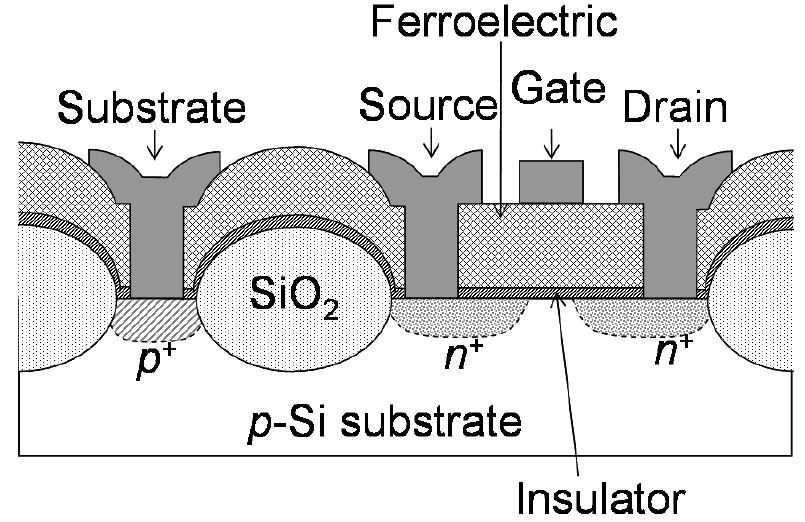
Figure 2. Drain current-gate voltage curves of an n -channel Pt/SBT/Hf-Al-O/Si FeFET at V = ±6.0 V. The inset was made by measuring the curves at V g and ±8.0 V. Scan voltage is each gate-voltage amplitude applied to the FeFET. The almost linearly increasing memory window shown in the inset indicates that ferroelectric polarization in the FeFET is not saturated even at V permission of